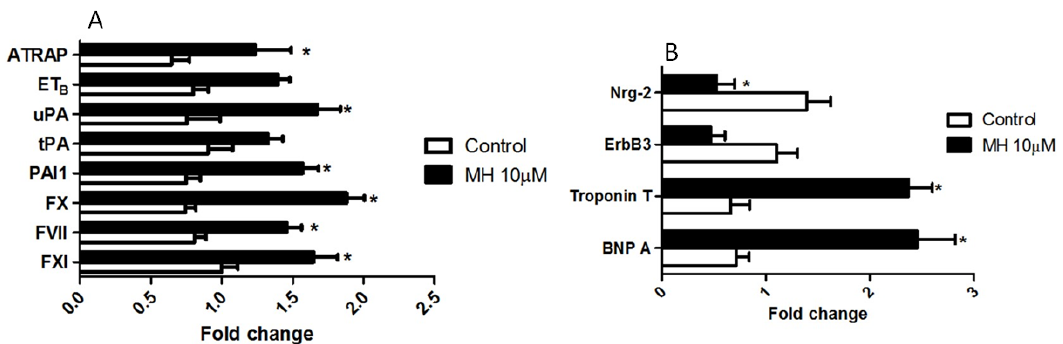
Figure 5. Embryos treated with MH lead to altered cardiac biomarker gene expression and altered expression of genes involved in thrombosis, fibrinolysis, and vascular tone. Real-time RT-qPCR was performed on total RNA isolated from each group of embryos using described primers in Table 1 leading to the amplification of the target gene. ( A ) RT-qPCR analysis of factor XI (FXI), factor VII (FVII), factor X (FX), plasminogen activator inhibitor 1 (PAI-1), tissue plasminogen activator (tPA), urokinase plasminogen activator (uPA), endothelin B (ETB), and angiotensin type 1 receptor associated protein (ATRAP) isolated from control and MH-treated embryos. ( B ) RT-qPCR analysis of natriuretic peptide A, Troponin T, ErbB3, and Nrg2. Data were normalized to the eukaryotic elongation factor 1-alpha (eEf1 α ) polymerase chain reaction signal. Each value represents mean ± SEM ( n = 100, replicated four times). * indicates a value is significant versus the respective control group ( p < 0.05).